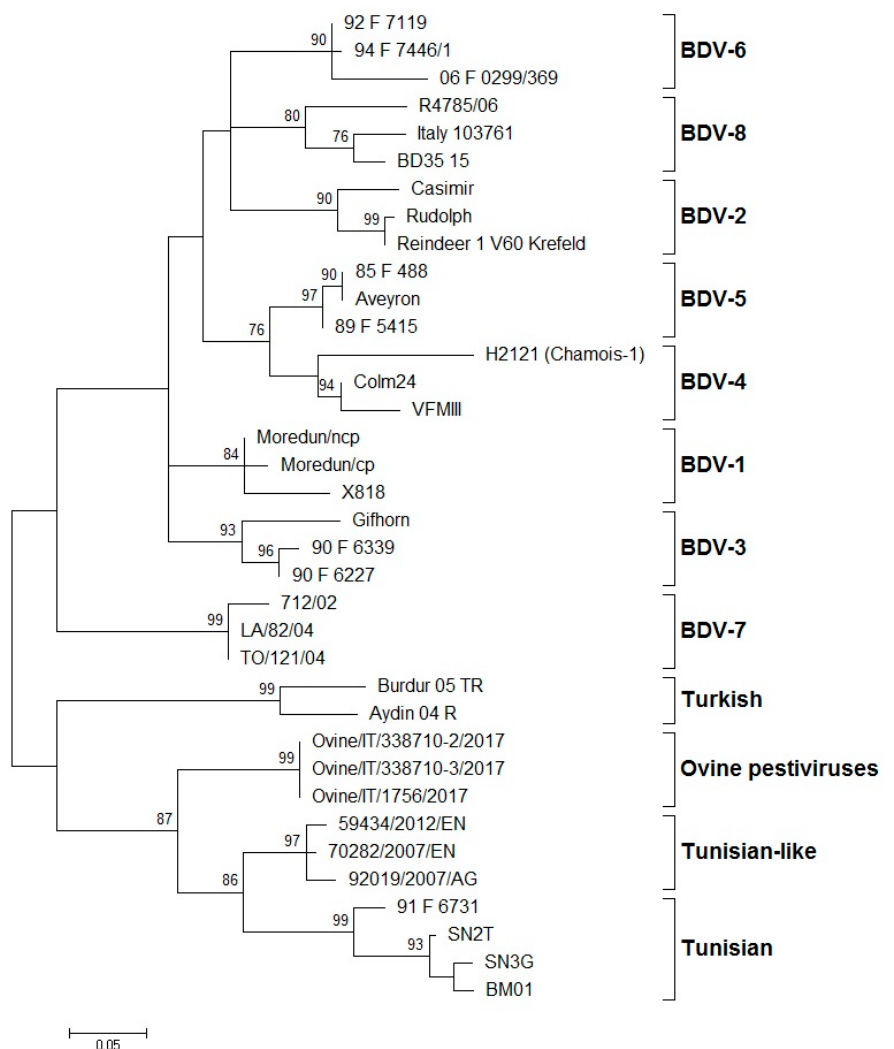
Figure 1. Phylogenetic tree showing the genetic relationship between pestivirus strains in the 5 ′ -UTR. The tree was based on an analysis of partial 225 nt-long sequences. It was prepared using the MEGA v.7 program employing the maximum-likelihood method with the GTR+G+I substitution model. GenBank accession numbers of sequence data used are: BDV-1: X818 (AF037405), Moredun